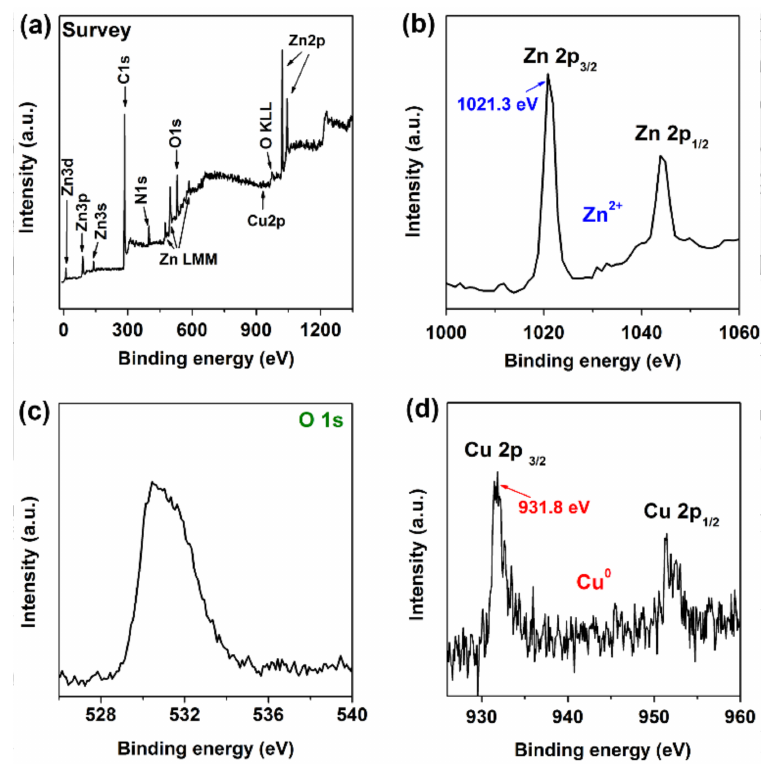
Figure 5. XPS of the Cu–ZnO@C compound prepared by heat-treated Complex at 600 ◦ C under N 2 . ( a ) Survey; ( b ) Zn 2p; ( c ) O 1s; ( d ) Cu